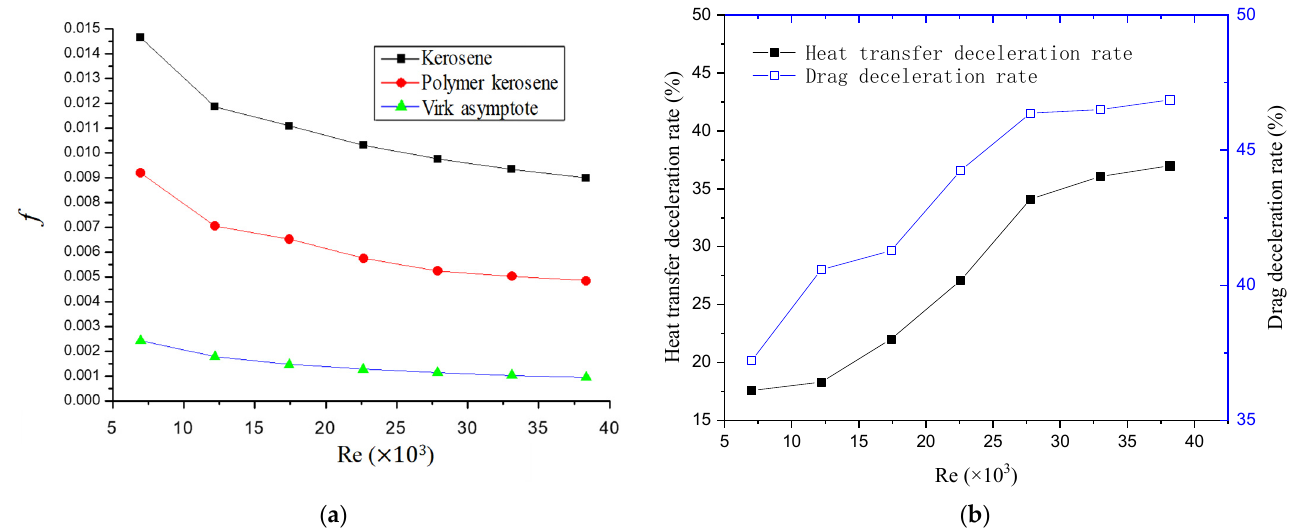
Figure 6. Influence on flow and heat transfer versus different Reynolds numbers, by the addition of polymer additive ( a ) Fanning friction coefficient, ( b ) heat transfer reduction rate and deceleration rate.